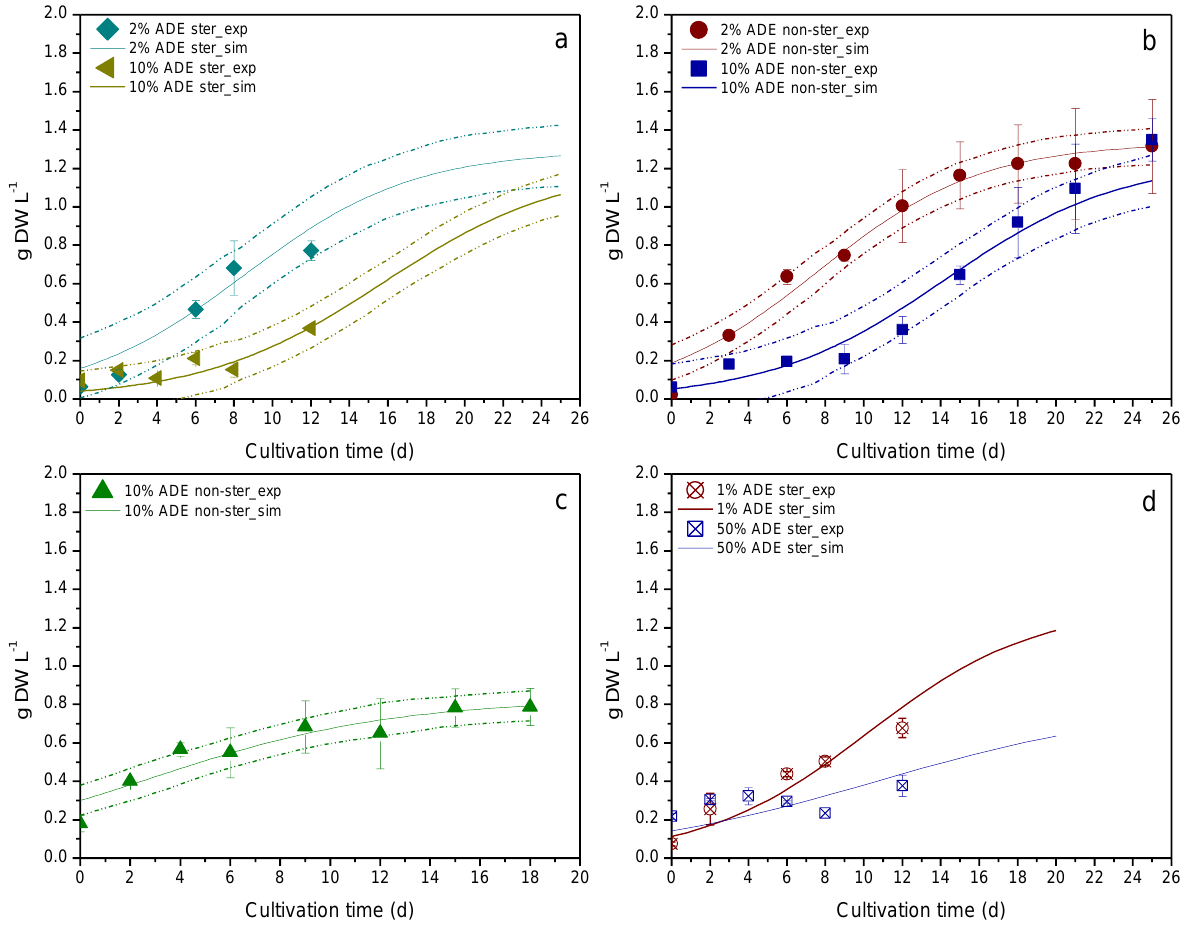
Figure 2. Experimental data and model fitting for biomass production of the microalgae P. kessleri , in 2% and 10% sterile digestate in Erlenmeyer flasks ( a ), 2% and 10% non-sterile digestate in Erlenmeyer flasks ( b ), 10% non-sterile digestate in PBR ( c ), and model prediction for species growth in 1% and 50% sterilized digestate in Erlenmeyer flasks ( d ).